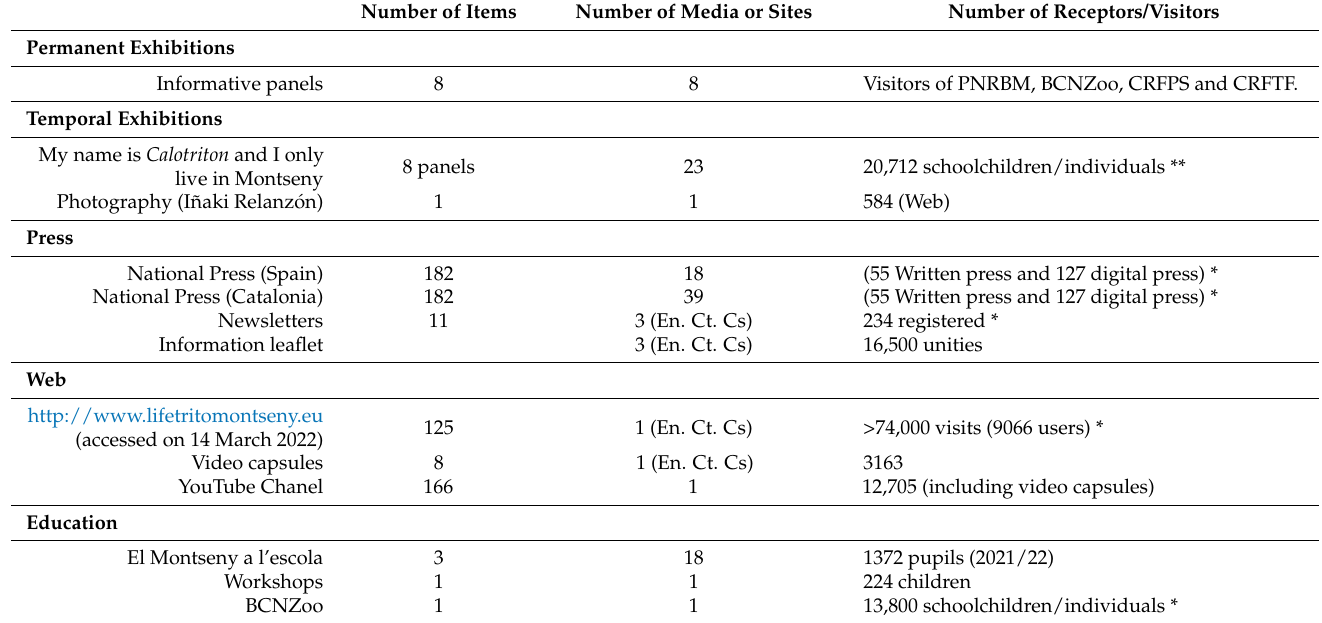
Table 5. Dissemination actions and informative material made during LIFETM. (En. Ct. Cs): English, Catalan and Castilian languages. (*): Data from 01/01/2017 to 12/31/2021. (**): Data from 1